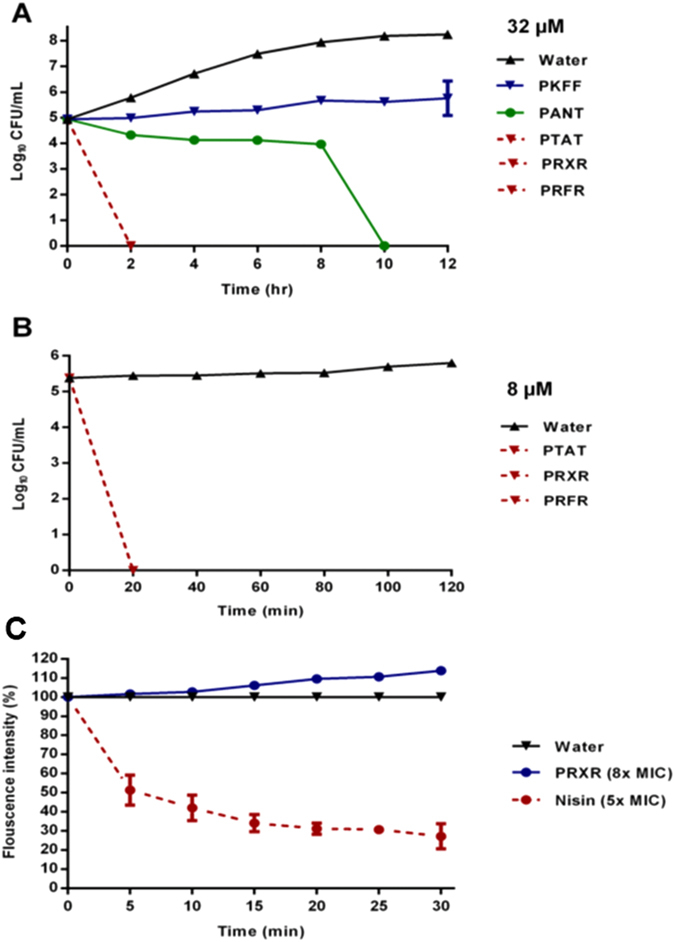
Time-kill analysis of PNAs against L. monocytogenes F4244. (A) 32 μM of the five PNAs at 37 °C were incubated for 12 hours and samples were collected every two hours. (B) 8 μM of PTAT, PRXR, and PRFR at 37 °C were incubated for 2 hours and samples were collected every 20 minutes. The results are presented as means ± SD from two independent experiments (n = 3). (C) Permeabilization of the cytoplasmic membrane of L. monocytogenes F4244 indicated by percent of calcein leakage for 30 min exposure to PRXR and nisin. Samples were collected every 5 minutes. The results are given as means ± SD (n = 3; data without error bars indicate that the SD is too small to be seen).